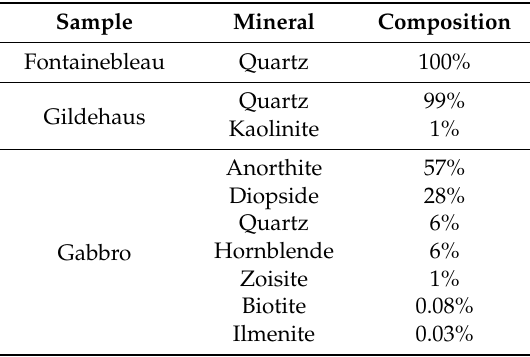
Table 1. Composition of the samples determined with quantitative